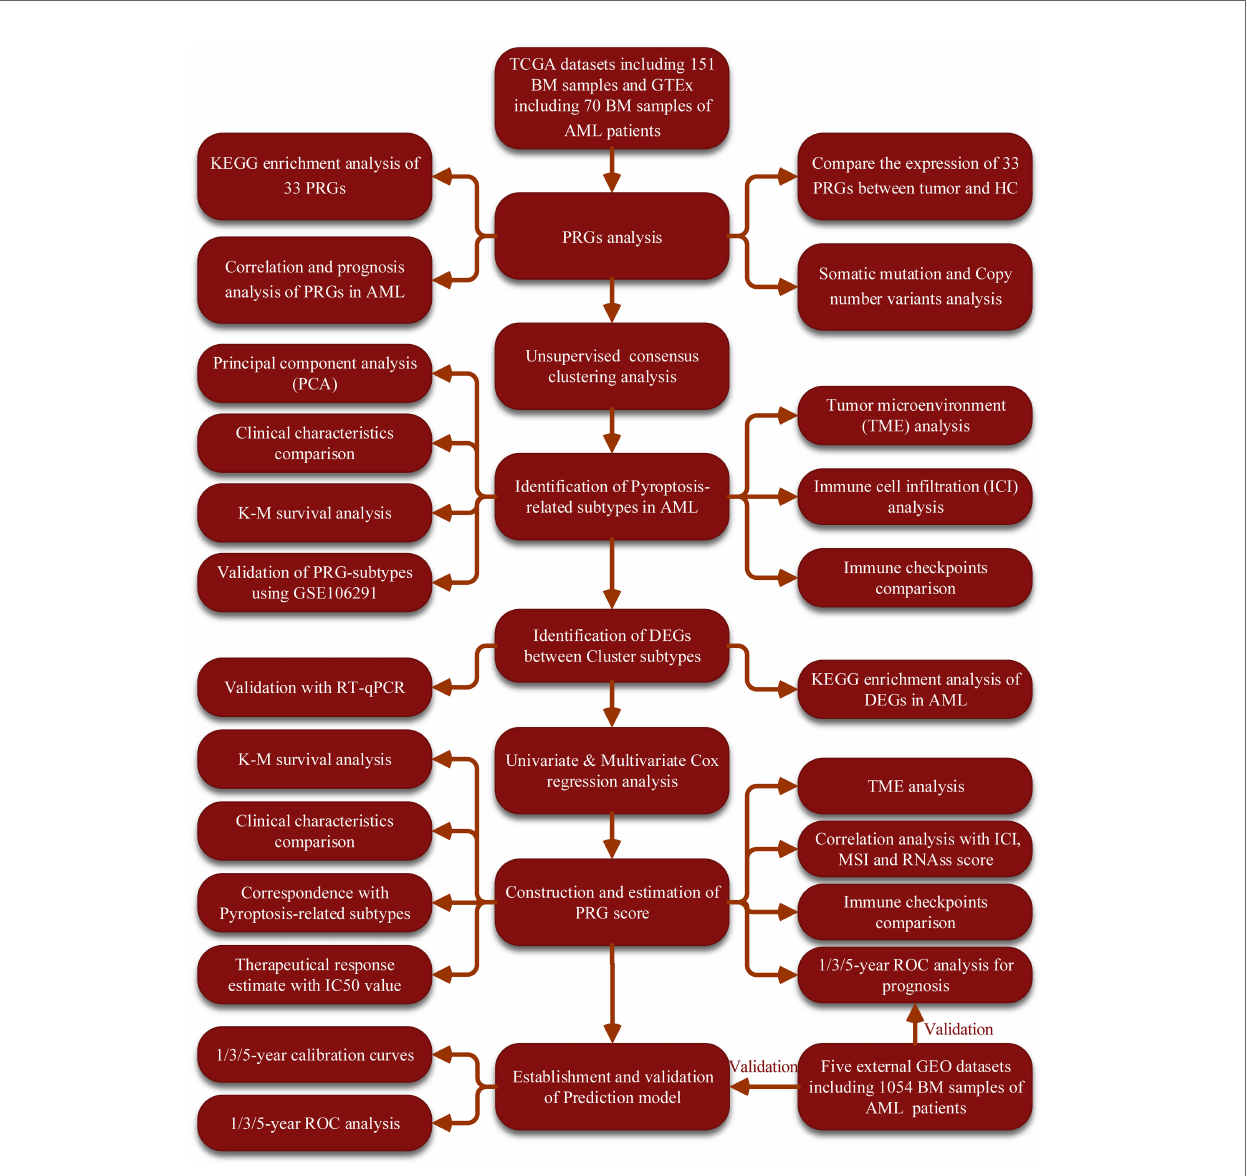
FIGURE 1 | The fl ow diagram of the work fl ow in this study. BM, bone marrow; AML, acute myeloid leukemia; PRGs, pyroptosis-related genes; PCA, principal component analysis; CNV, Copy number variants; TME, tumor microenvironment; ROC, receiver operating characteristic; IC50, half-maximal inhibitory concentration; ICI, Immune cell in fi ltration; MSI, microsatellite